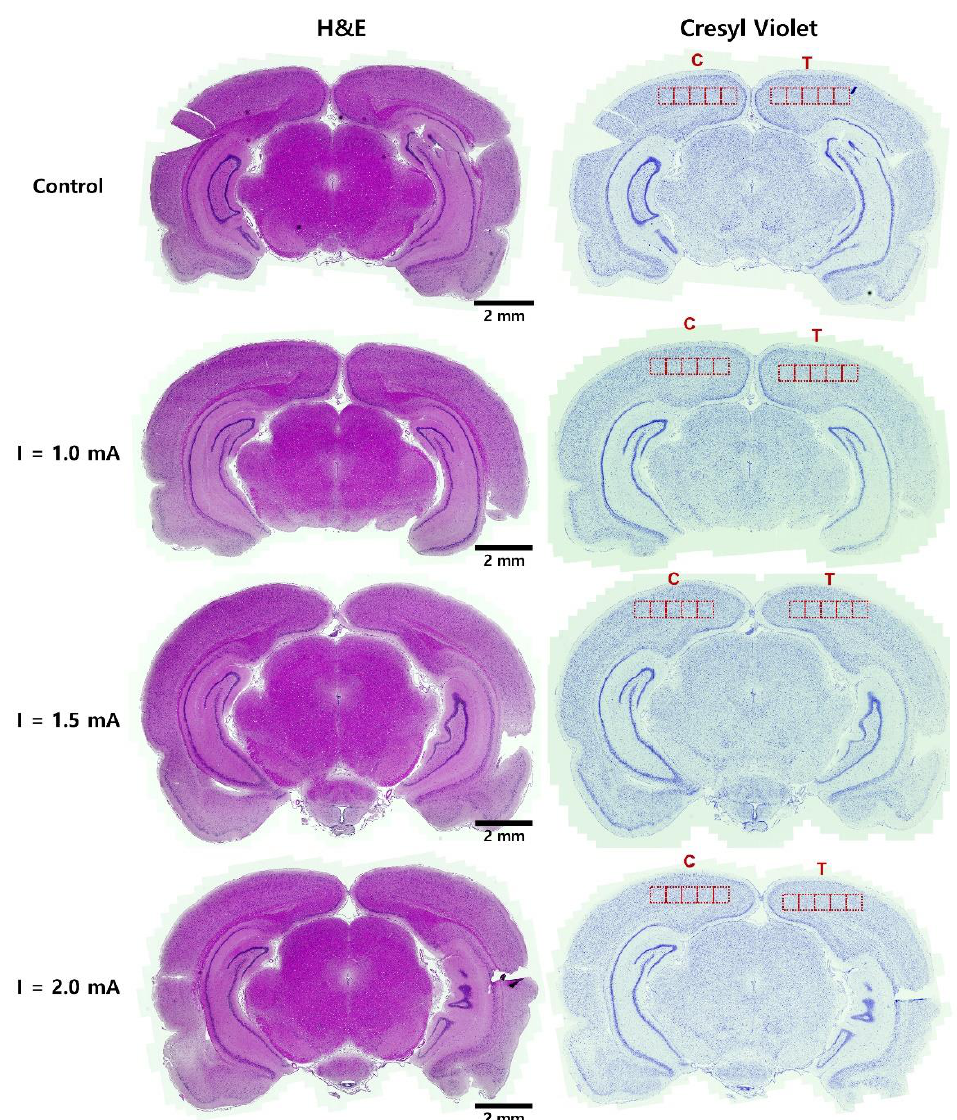
Figure 4. Histopathological slide scan images of H&E and Cresyl violet-stained brain tissue slides under each current condition (I = 0.0 (control), 1.0, 1.5, and 2.0 mA) of 10 Hz tACS. Red boxes indi- cate regions of sub-images segmented for quantitative analysis of a number of Nissl bodies. (T: Transcranial alternating current stimulation-applied region, C: Contralateral region).